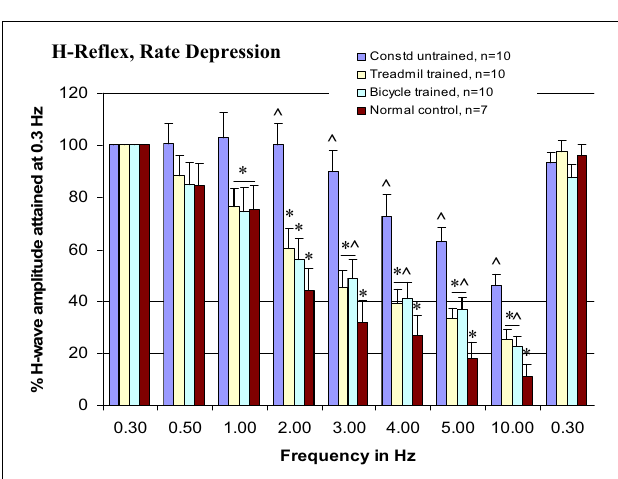
velocity-dependent ankle torque (C) and time-locked EMG-RMS magnitude (D) over 12weeks. Both treadmill and bicycle training prevented the initial hyporeflexic state (at week 2), prolonged the transition to develop a permanent hyperreflexic state (weeks 4–6) and attenuated the level of spasticity (weeks 8–12).